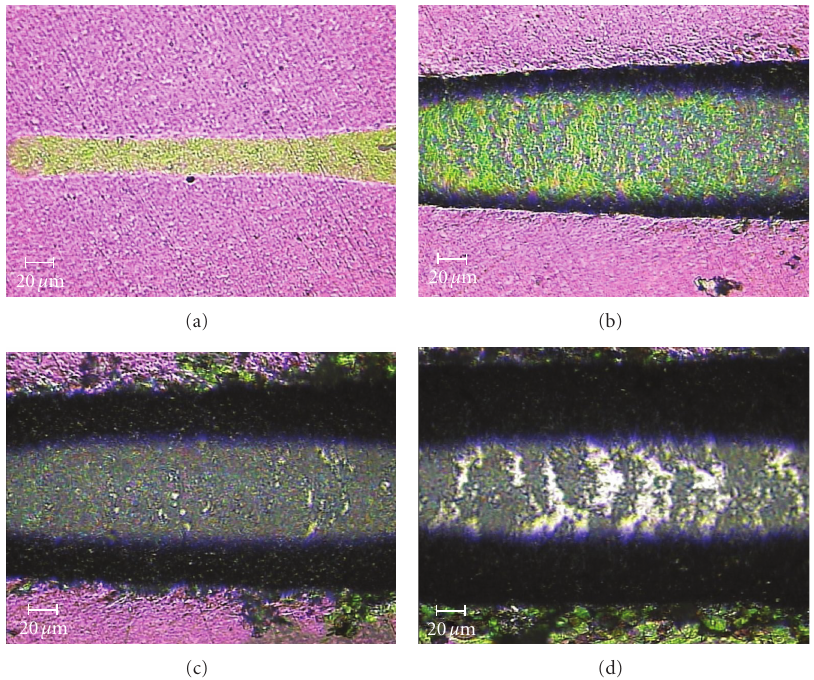
Figure 9: Scratch test for NbN coating (deposited at N 2 /Ar flow = 20%) on SS at (a) 1N, showing start of the scratch, (b) 12 N, revealing segregation, cracks and pores, (c) 22N displaying chipping, cracks, pores, pile-up, and (d) 32 N, showing chipping, cracks, pores, pile-up, and